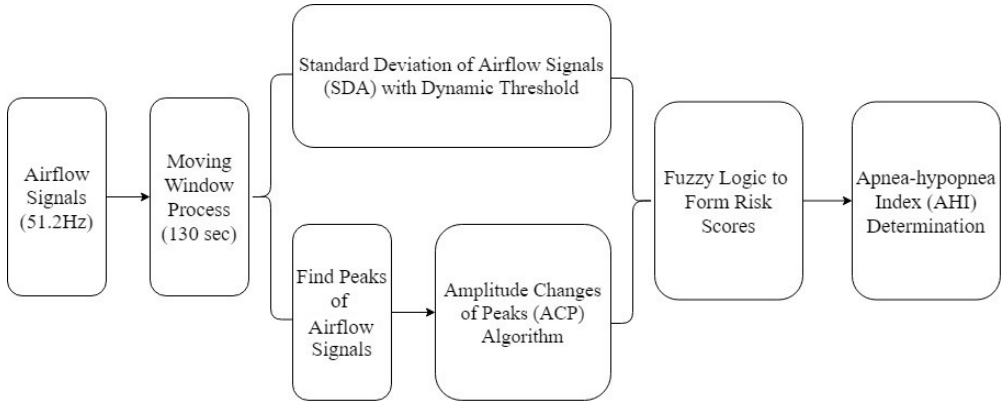
Figure 1. System block of apnea-hypopnea index (AHI) detection.